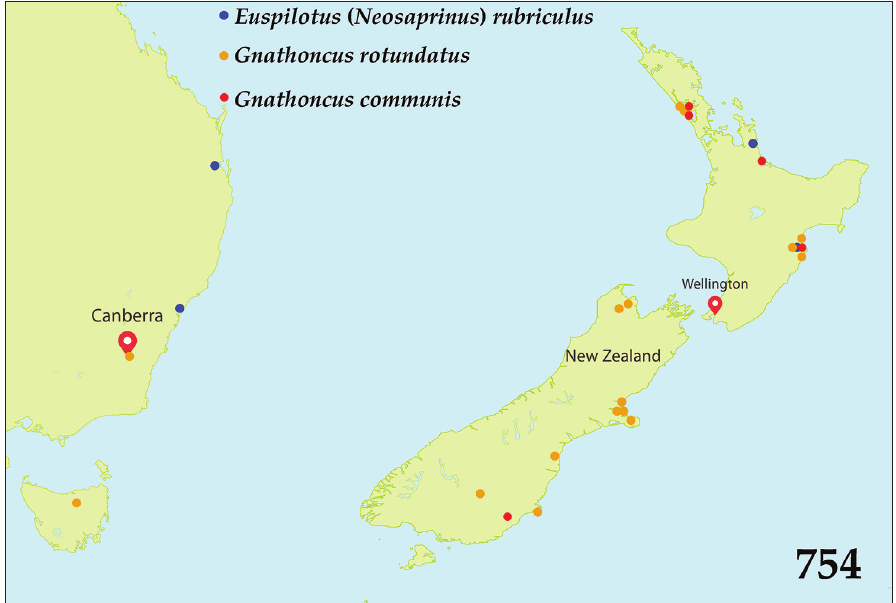
Figure 754. Distribution of Euspilotus ( Neosaprinus ) rubriculus (Marseul, 1855) in New Zealand and Australia; Gnathoncus communis (Marseul, 1862) in New Zealand and Gnathoncus rotundatus (Kugelann, 1792) in Australia and New